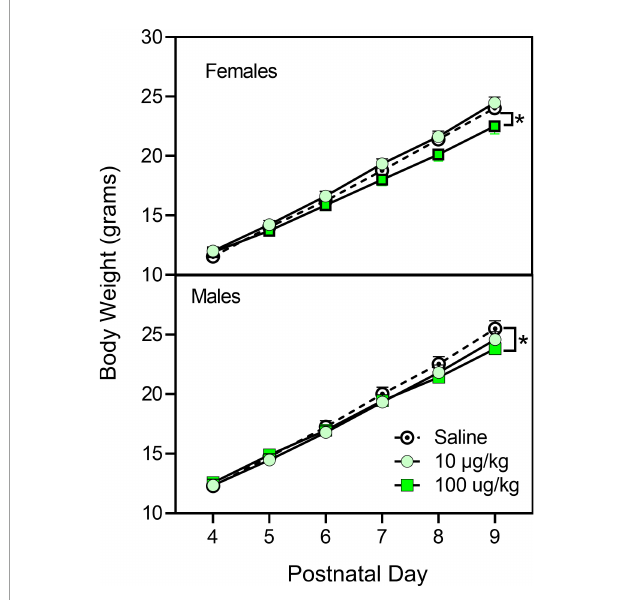
FIGURE1 Mean ( ± SEM) body weight of male and female rats ( n = 8–9/sex) treated with saline or fentanyl (10 or 100 µ g/kg) from PD 4 to PD 9. *Significant difference between vehicle- and 100 µ g/kg fentanyl-treated rats of the same